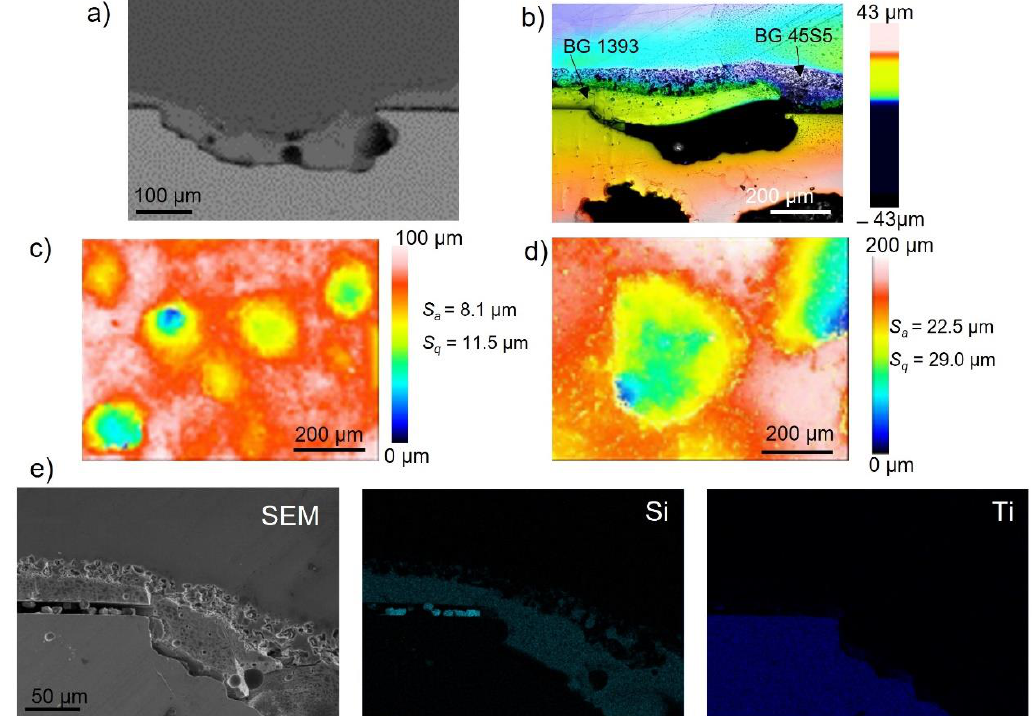
Figure 3. ( a ) SEM image of the cross-section view of the larger pore size samples; ( b ) measure of the Scheme 50. vol.% and 355 – 500 µm pores range size; ( c ) top-view CLM image of the 50 vol.% and 100 – 200 µm; ( d ) top-view CLM image of the 50 vol.% and 355 – 500 µm; and ( e ) SEM image and corresponding Si and Ti mapping acquired by EDS-SEM.